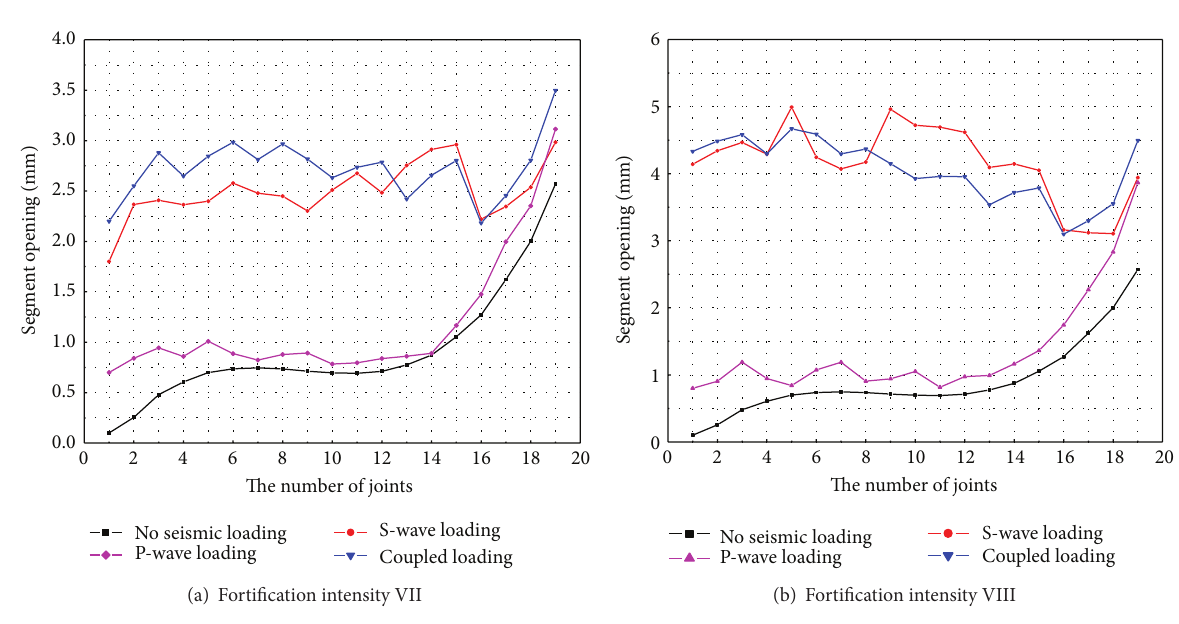
Figure 9: Segment opening under various seismic loading